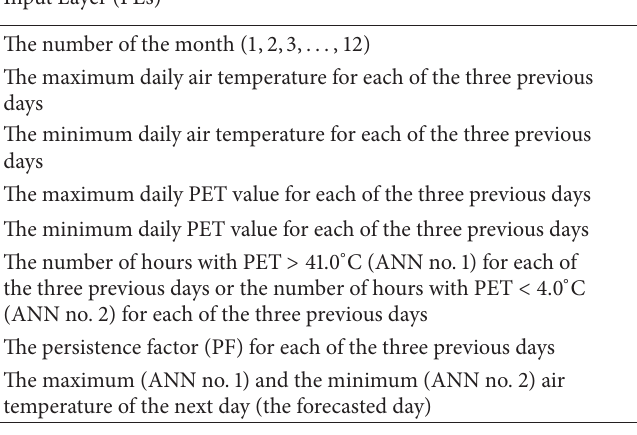
Output layer (targets values)